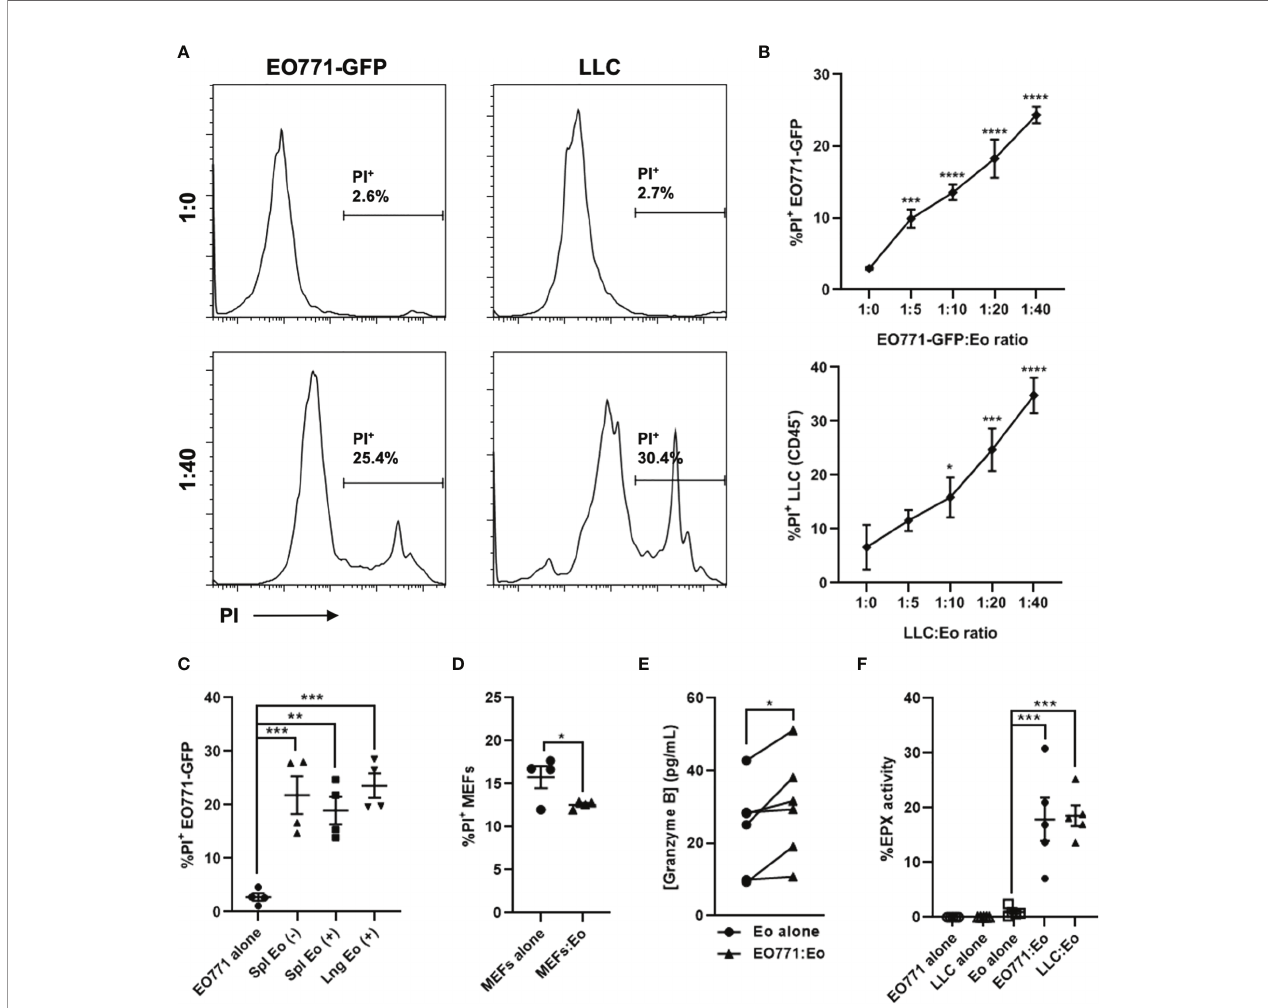
FIGURE 2 | Eosinophils are directly cytotoxic to tumor cells ex vivo . Eosinophils (Eo) were isolated from a naïve IL5Tg spleen or lungs and co-cultured with EO771- GFP or Lewis lung carcinoma (LLC) tumor cells at varying ratios for 6 hours. (A) Representative histograms of PI + EO771-GFP or LLC (gated on CD45 - ) tumor cells cultured alone (1:0) or co-cultured with splenic eosinophils at a 1:40 T:E ratio. (B) Frequency of PI + EO771-GFP and LLC cells co-cultured with splenic eosinophils at indicated T:E ratios. (C) Frequency of PI + EO771-GFP cells cultured alone or co-cultured with splenic and pulmonary eosinophils at a 1:20 T:E ratio. (+) refers to eosinophils isolated via positive selection and (-) refers to eosinophils isolated via depletion. (D) Frequency of PI + murine embryonic fi broblasts (MEFs) cultured alone or co-cultured with splenic eosinophils at a 1:10 T:E ratio. (E) Quanti fi cation of Granzyme B secreted by splenic eosinophils cultured alone or with EO771-GFP cells at a 1:40 T:E ratio. (F) Secreted EPX activity (as measured via the OPDmethod)in supernatants of splenic eosinophiltumorcellco-cultures at a 1:40 T:E ratio, as wellas eosinophils and tumor cells incubated alone. Data points aremean ± SEM of 3-6 independent experiments. *p < 0.05; **p < 0.01; ***p < 0.001; ****p <